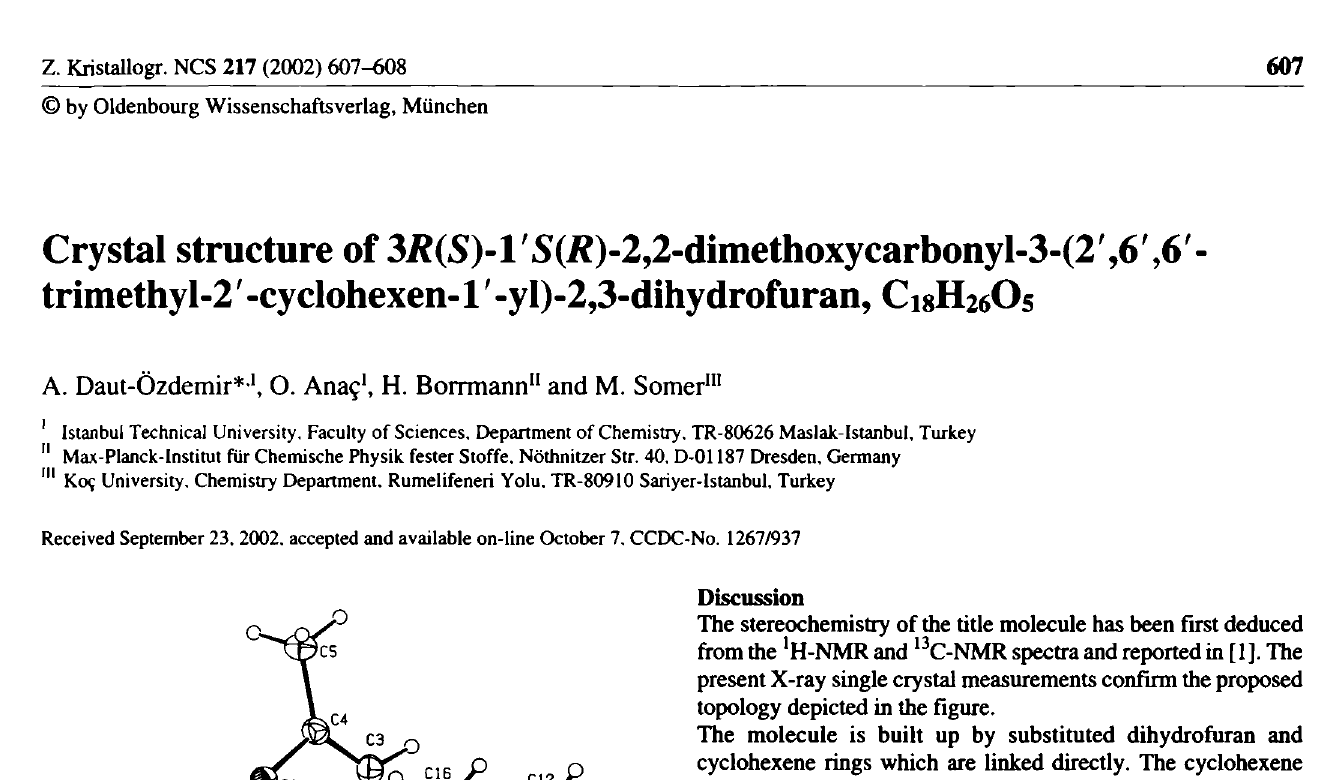
Table 2. Atomic coordinates and displacement parameters (in Â 2